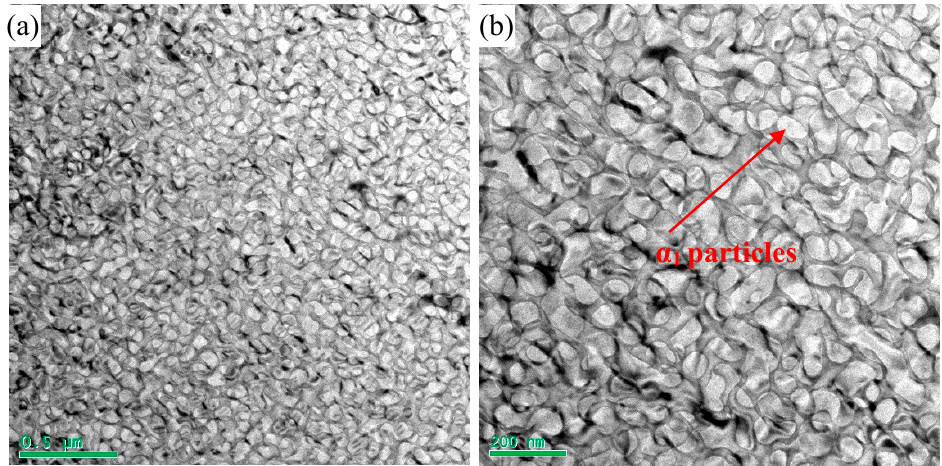
Figure 9. Bright-field image of the Fe-25Cr-15Co alloy with SAA (1 h solution treatment); ( a ) at lower magnification and ( b ) at higher magnification.